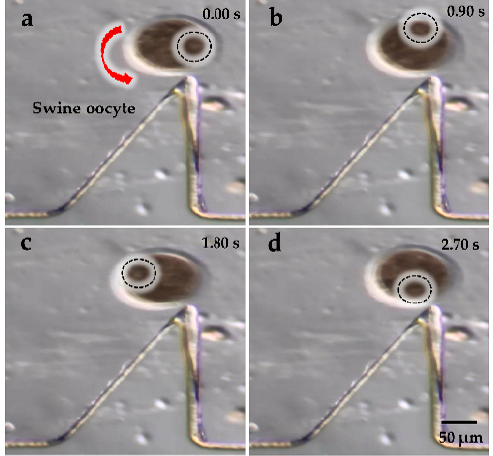
Figure 8. (a – d ) Rotational manipulation of the swine oocyte at 4.6 kHz and 20 V p-p . Figure 8. ( a – d ) Rotational manipulation of the swine oocyte at 4.6 kHz and 20 V p-p